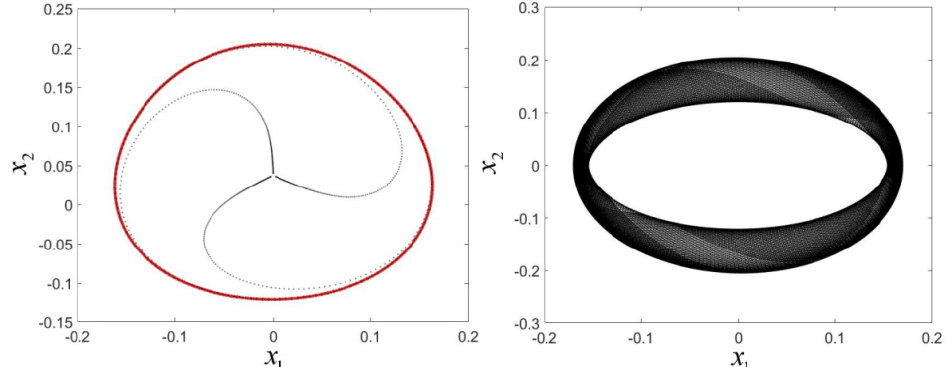
Figure 3. The stable quasi-periodic motion in 1:3 resonance when µ = 0.01: ( left ) the stable invariant circle; ( right ) the stable quasi-periodic motion.